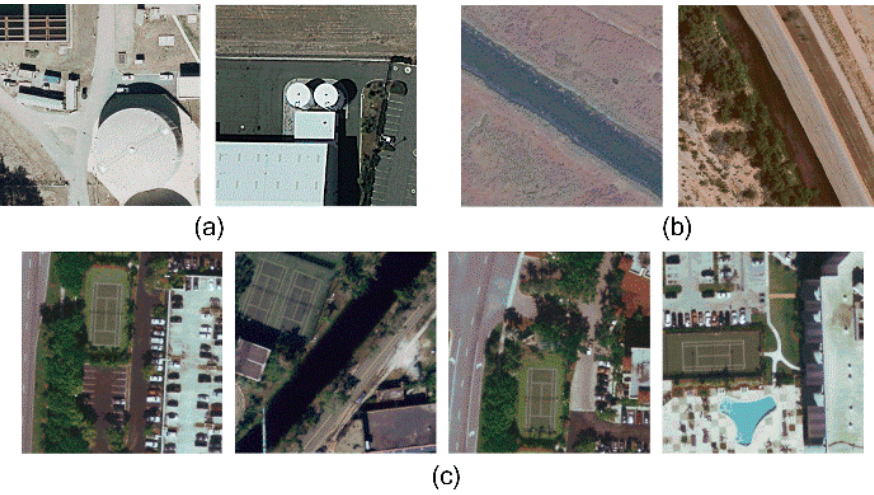
Figure 7. Some images are predicted correctly by the HCV, but not by the FV on the LU database: ( a ) storage tanks images; ( b ) river images; ( c ) tennis courts images.